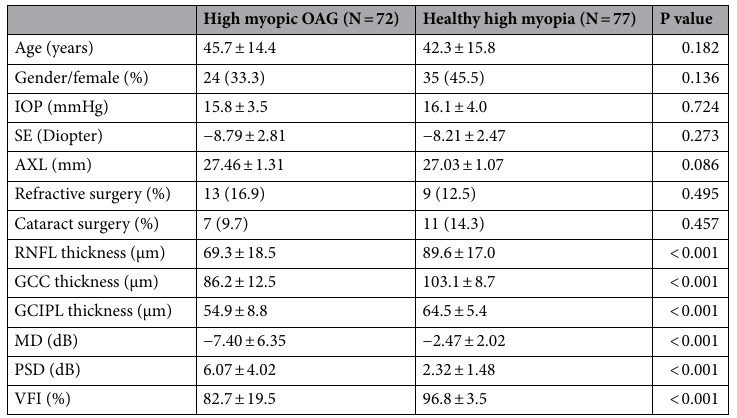
Table 1. Clinical demographic characteristics of the participants. The data are expressed as means ± standard deviation or no. (%). Comparisons are performed using the chi-square test for categorical variables and the independent t-test for continuous variables. OAG open angle glaucoma, IOP intraocular pressure, SE spherical equivalence, AXL axial length, RNFL retinal nerve fiber layer, GCC ganglion cell complex, GCIPL ganglion cell inner plexiform layer, MD mean deviation of visual field, PDS pattern standard deviation of visual field, VFI visual field